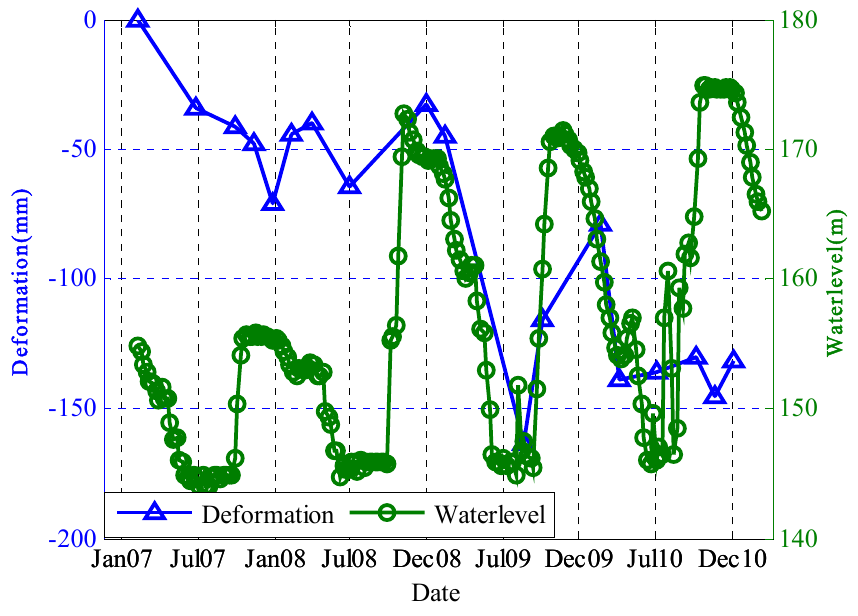
Figure 6. Time series of deformation at point P along down-slope direction from Advanced Land Observing Satellite (ALOS) Phased Array L-band Synthetic Aperture Radar (PALSAR) data and water level in Three Gorges Reservoir. The location of point P is shown in Figure